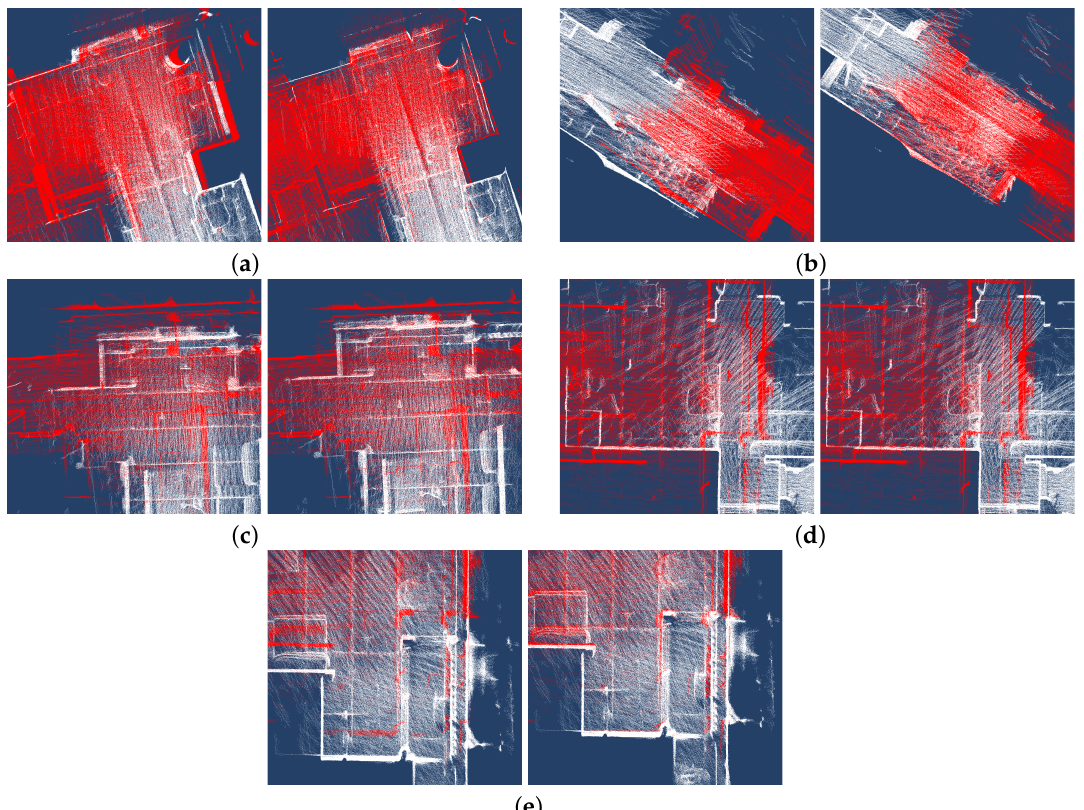
Figure 5. Results on the dataset pairs. Left image shows resulting alignment before ICP refinement and the right one after ICP refinement. Pairs: ( a ) A-B, ( b ) B-C, ( c ) C-D, ( d ) D-E, ( e )